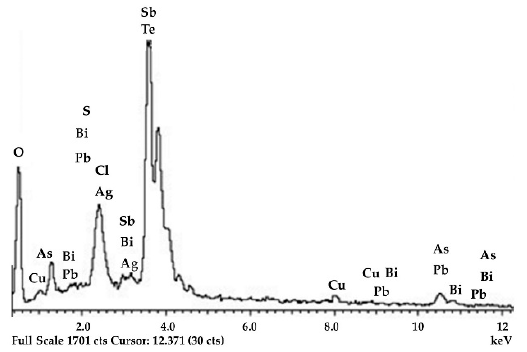
Figure 12. Spectrum of the oxidized O-Sb-Pb phase (with traces of Cu-Bi-Cl-Ag).